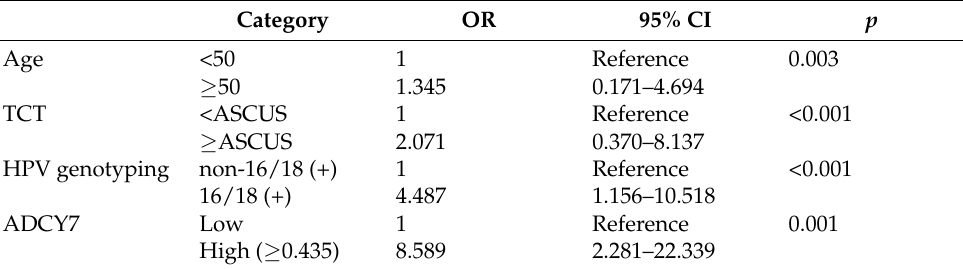
Figure 1. Expression patterns of ADCY7 mRNA in cervical lesions. ( A ) ADCY7 expression in different cervical lesions. ( B ) ADCY7 expression in different cervical cytology. ( C – I ) ADCY7 expression in different ADCY7 genotyping. Analysis between two groups: Wilcoxon rank-sum test; ns: p = 0.05 or higher; ** p < 0.01; *** p < 0.001. Table 2. Independent predictors for the detection of CIN2+